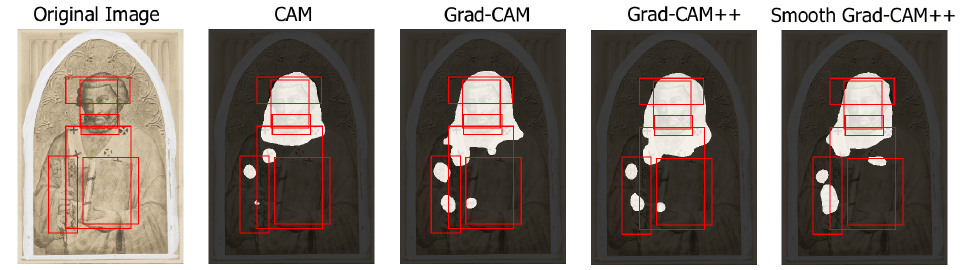
Figure 14. Class activation maps extracted from a drawing of Saint Peter. Four out of five symbols are identified despite their low visibility.